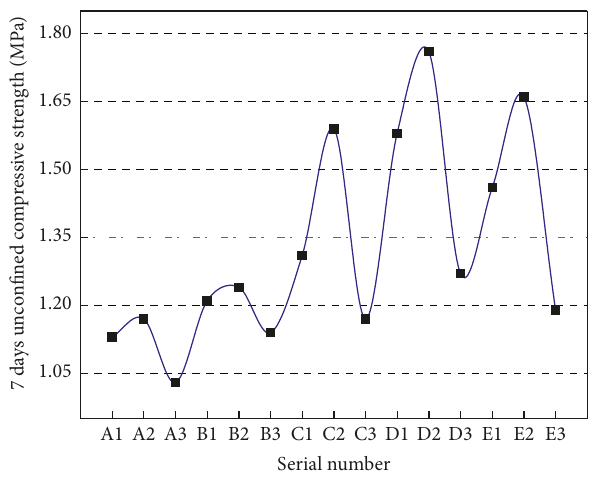
Figure 5: Unconfined compressive strength of specimen for 7